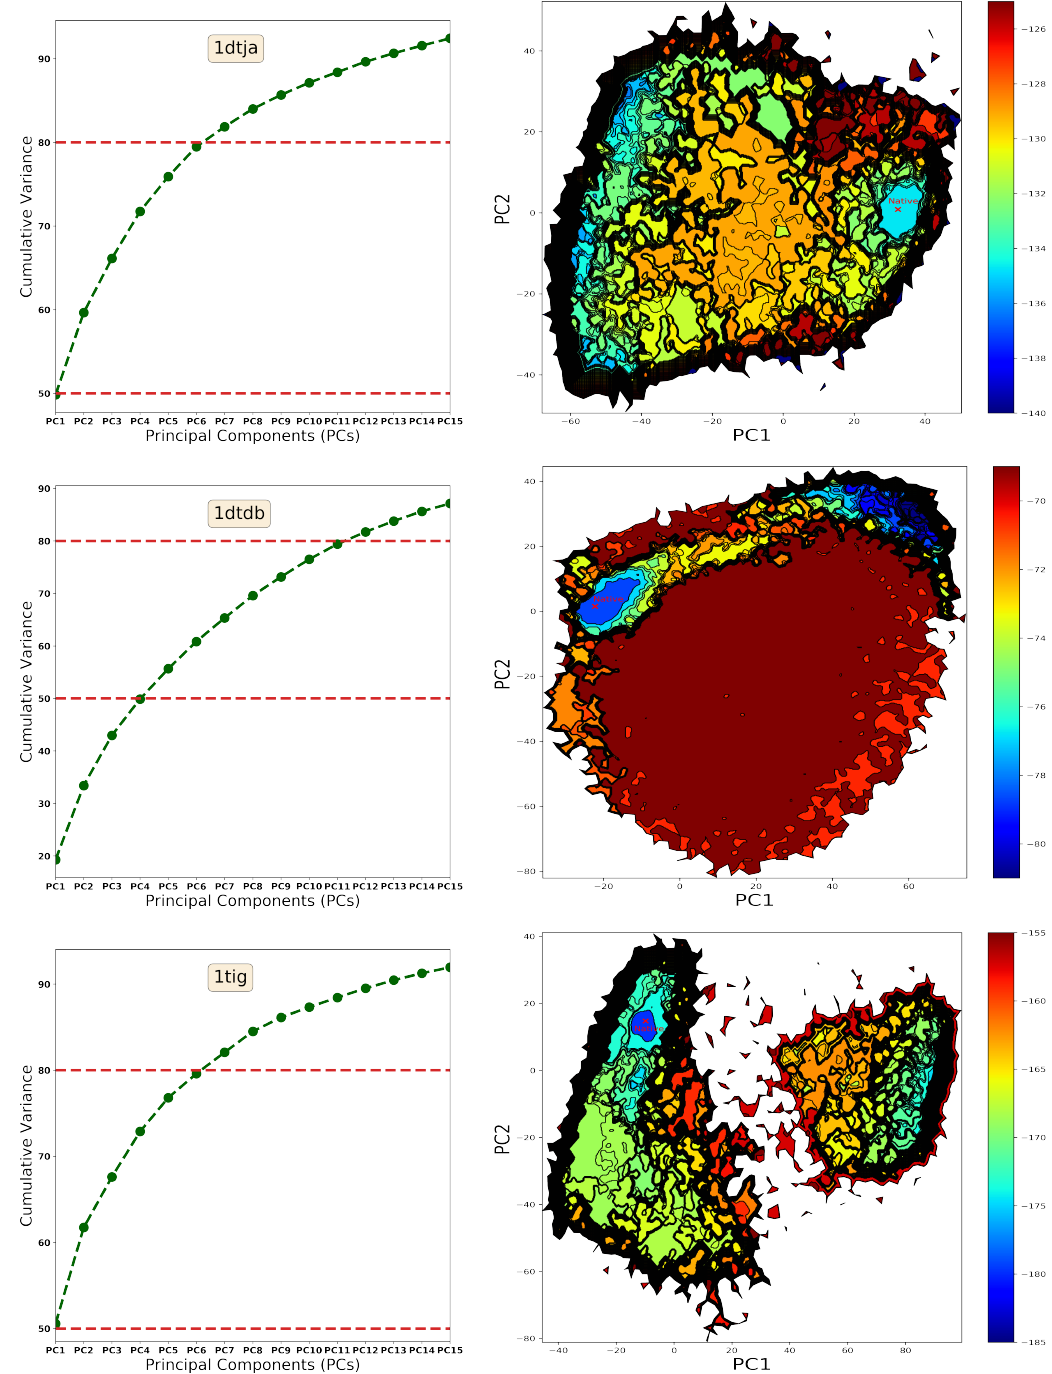
Figure 2. Results are shown the easy targets. The left panel shows the accumulation of variance for the PCs obtained from PCA of generated decoys. The right panel shows the reconstructed landscape over the PC1-PC2 grid. The contour lines show the basin boundaries. The location of a known native structure for each target protein from the easy category highlighted here is marked by a red